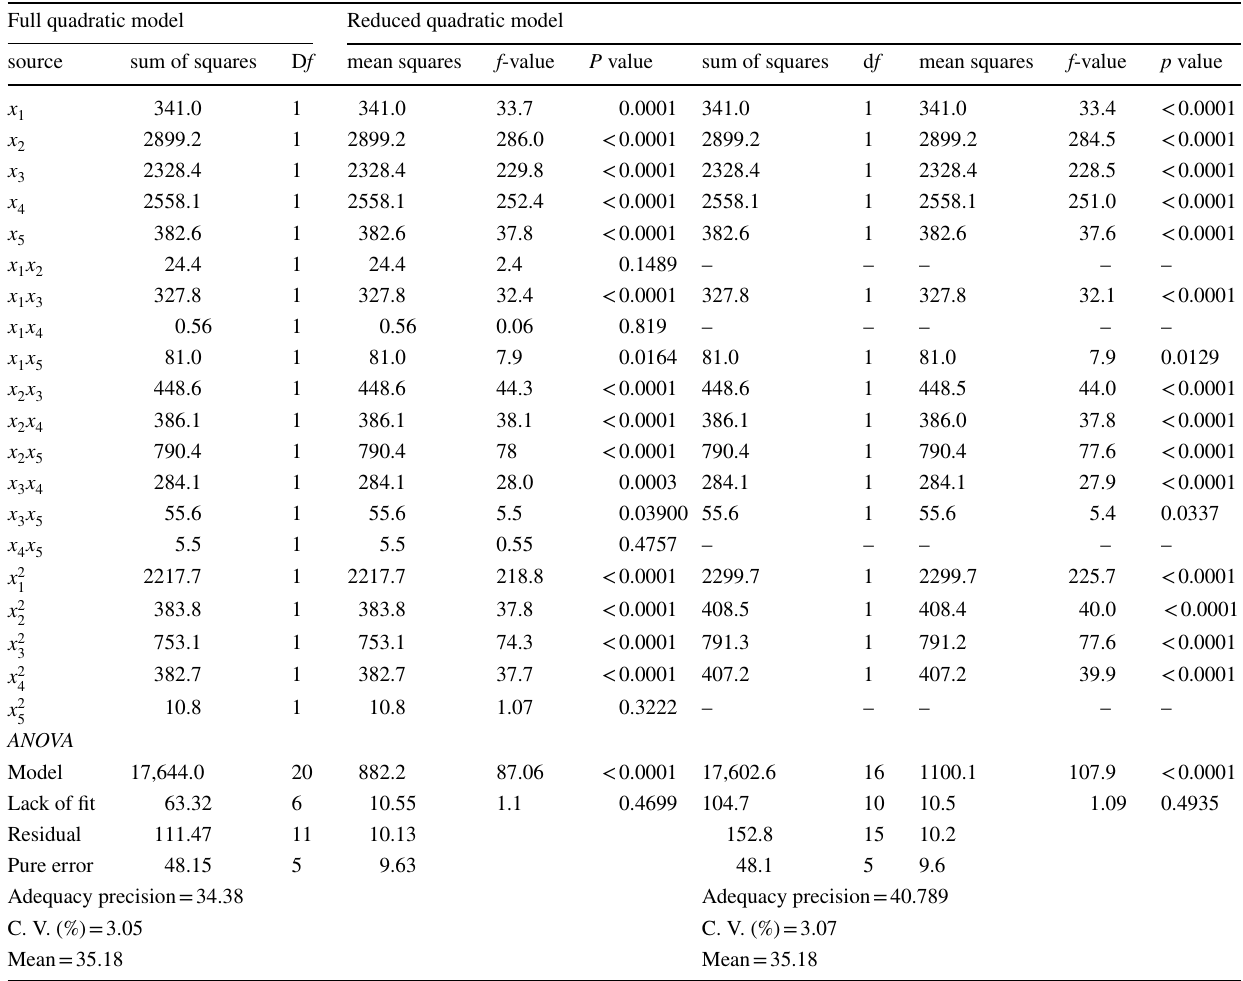
Table 5 Test of significance for model coefficients and analysis of variance Full quadratic